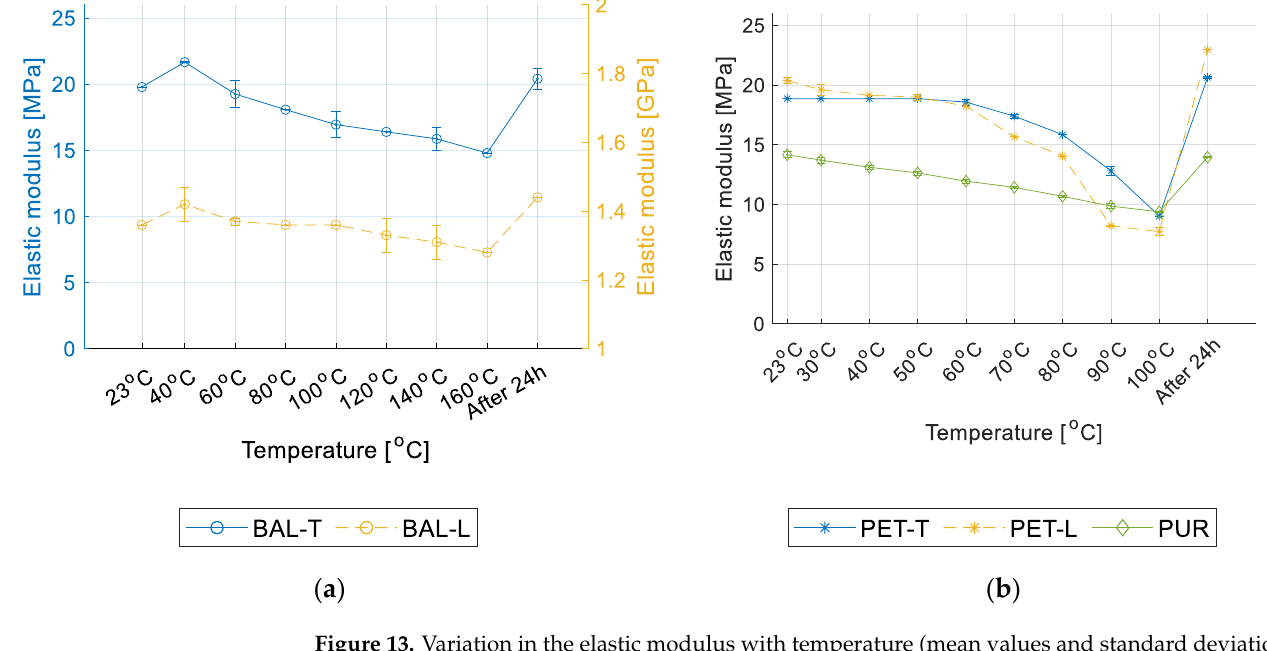
Figure 13. Variation in the elastic modulus with temperature (mean values and standard deviation): ( a ) balsa; ( b ) PUR and PET. ( a ) balsa; ( b ) PUR and